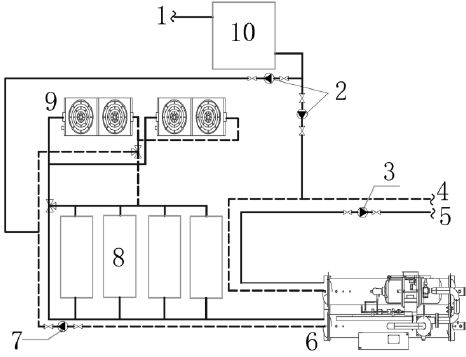
Figure 3. The heat pump heating system